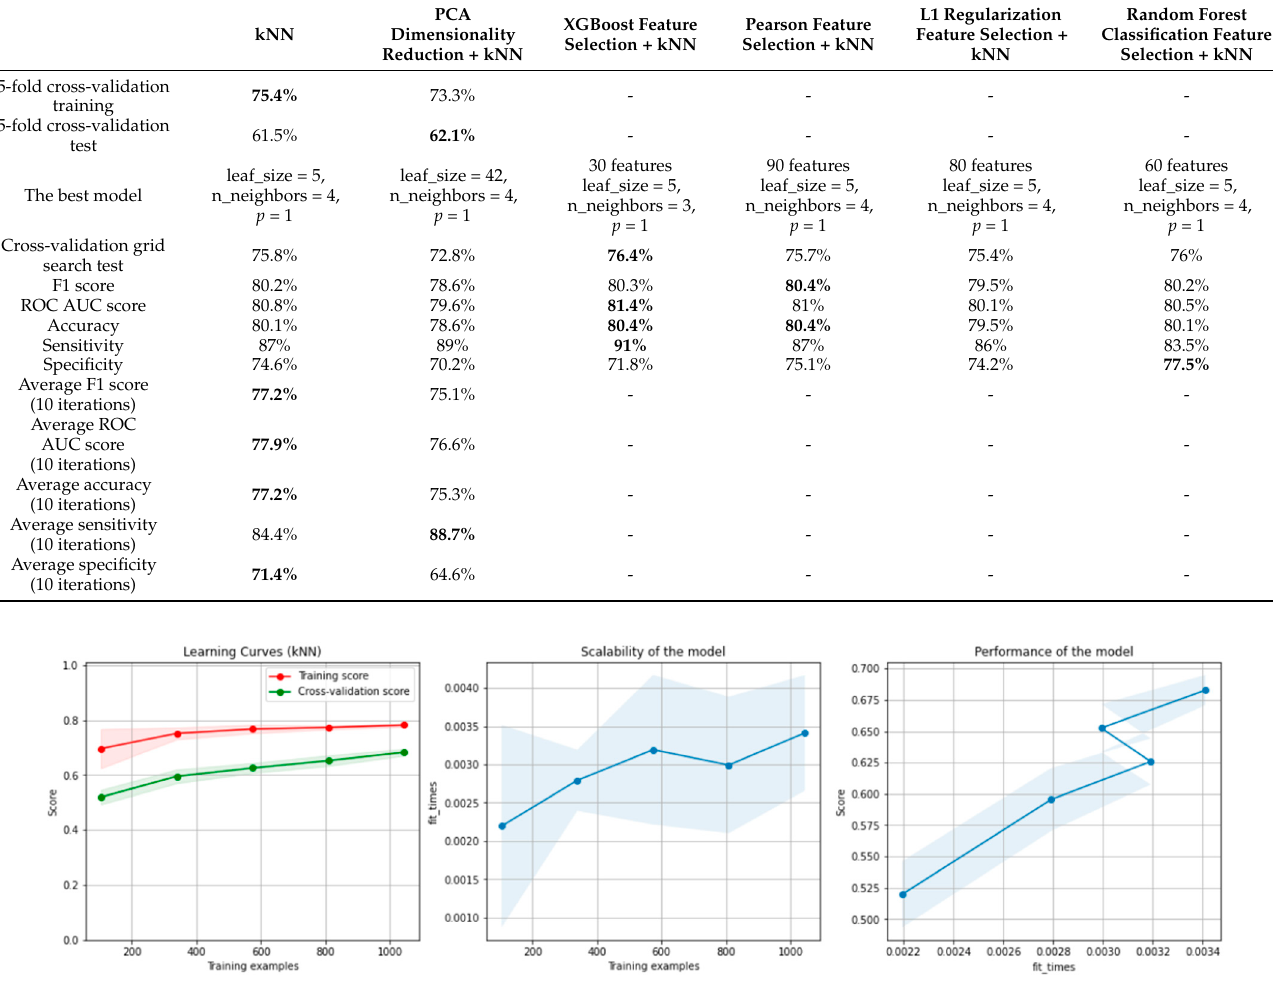
Figure 11. Learning curves, scalability and model performance for the PCA + kNN algorithm, for the non-overlapping dataset.